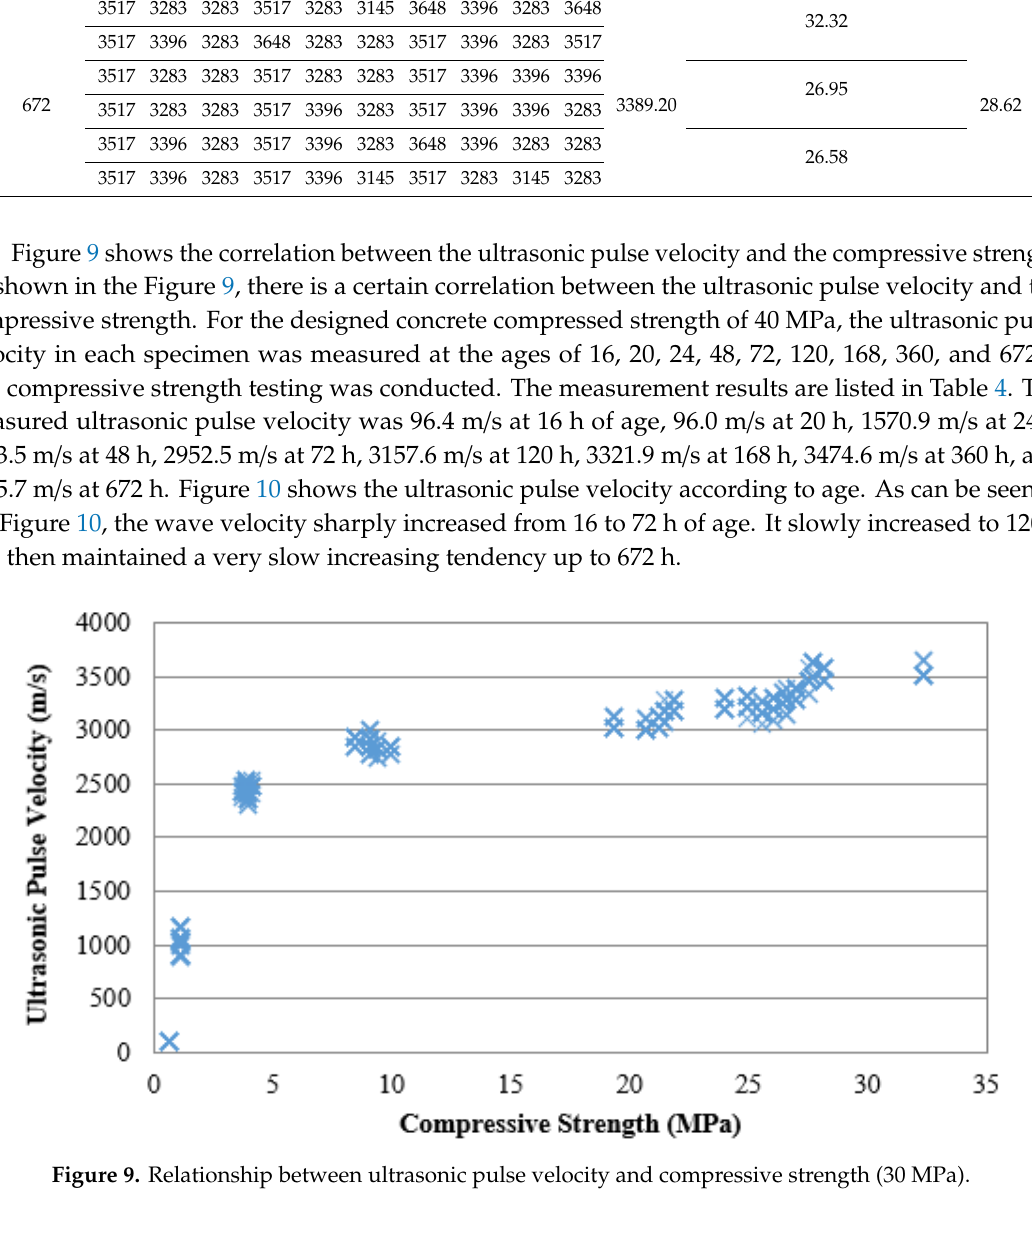
Figure 10. Ultrasonic pulse velocity with age (40 MPa). Figure 11 shows the concrete compressive strength according to age. As shown in the Figure 11, the concrete compressive strength was 1.55% of the designed strength at 16 h of age, 1.55% at 20 h, 2.80% at 24 h, 16.05% at 48 h, 38.33% at 72 h, 69.43% at 120 h, 83.85% at 168 h, 85.38% at 360 h, and 85.48% at 672 h. These results indicate that the compressive strength increased as the age increased. Figure 12 shows the correlation between the ultrasonic pulse velocity and the compressive strength. The Figure 12 shows that there is a certain correlation between the ultrasonic pulse velocity and the compressive strength.